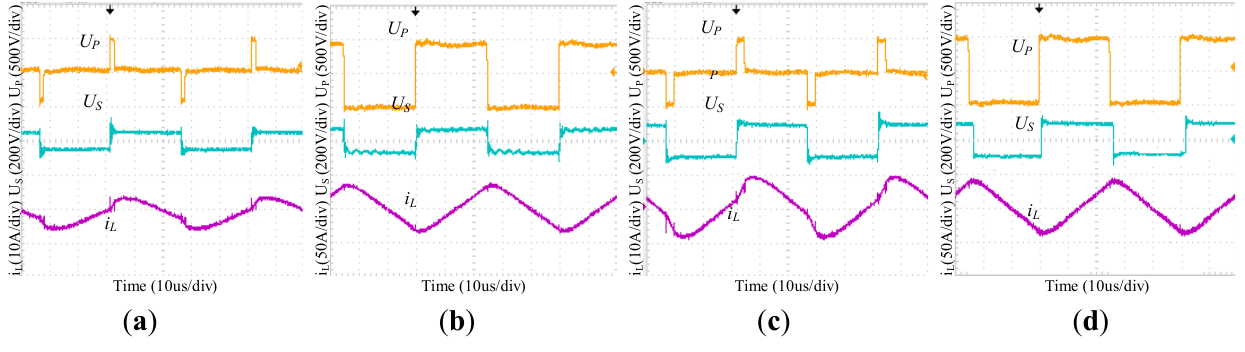
Figure 11. The experimental waveforms of ESPS and CSPS control when output voltages U are 50 V and 100 V. ( a ) ESPS control with U 2 with U = 500 V, U = 50 V; ( c ) ESPS control with U 1 2 control with U = 500 V, U = 100 V. 1 2